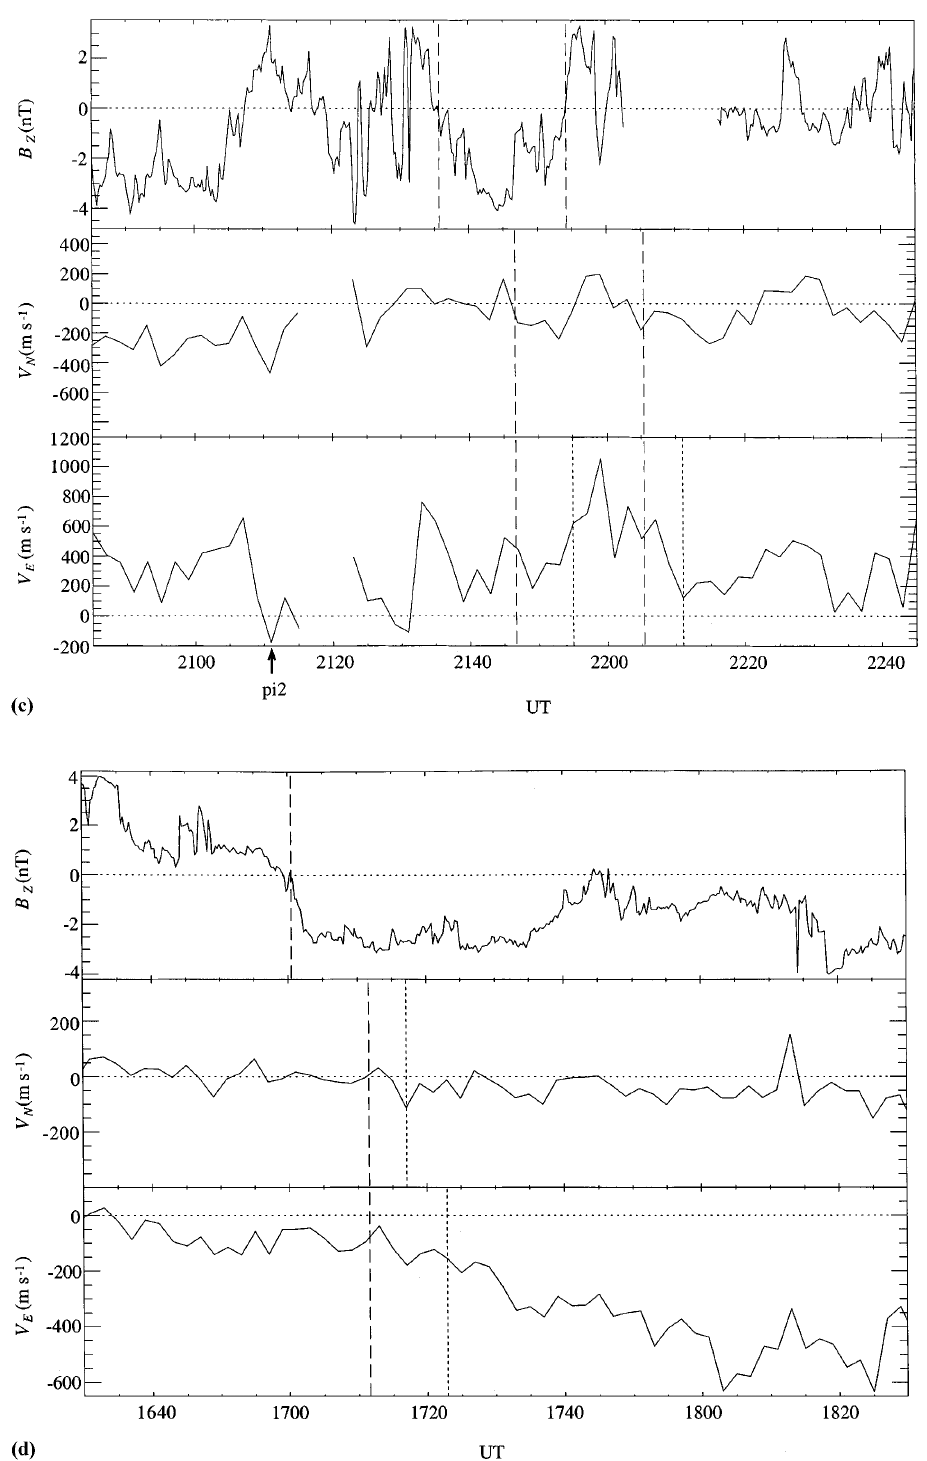
Fig. 6. c As for Fig. 2, except for the interval 2045–2245 UT (2315– 0115 MLT) on 15